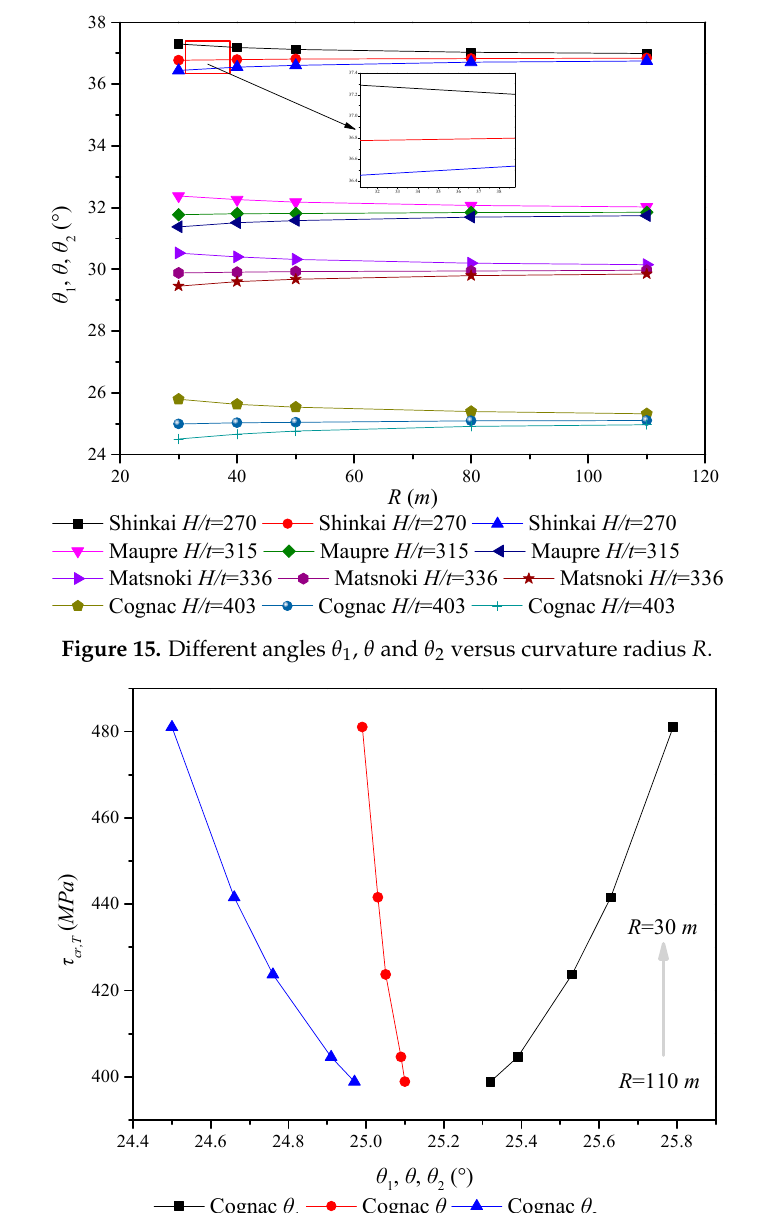
Figure 14. Comparison of global shear buckling strength of a corrugated web used in a straight bridge ( R = ∞ ) and a curved bridge ( R = 110 m).